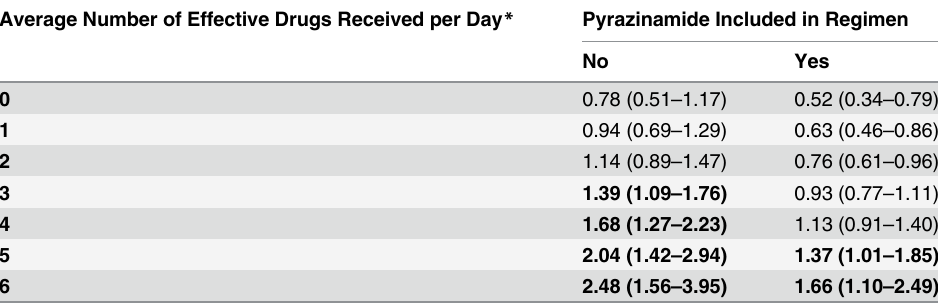
Table 4. Multivariable model 2 adjusted hazard ratios for sputum culture conversion associated with inclusion of one additional untested drug in the regimen, stratified by average number of effective drugs received per day and inclusion of pyrazinamide in the